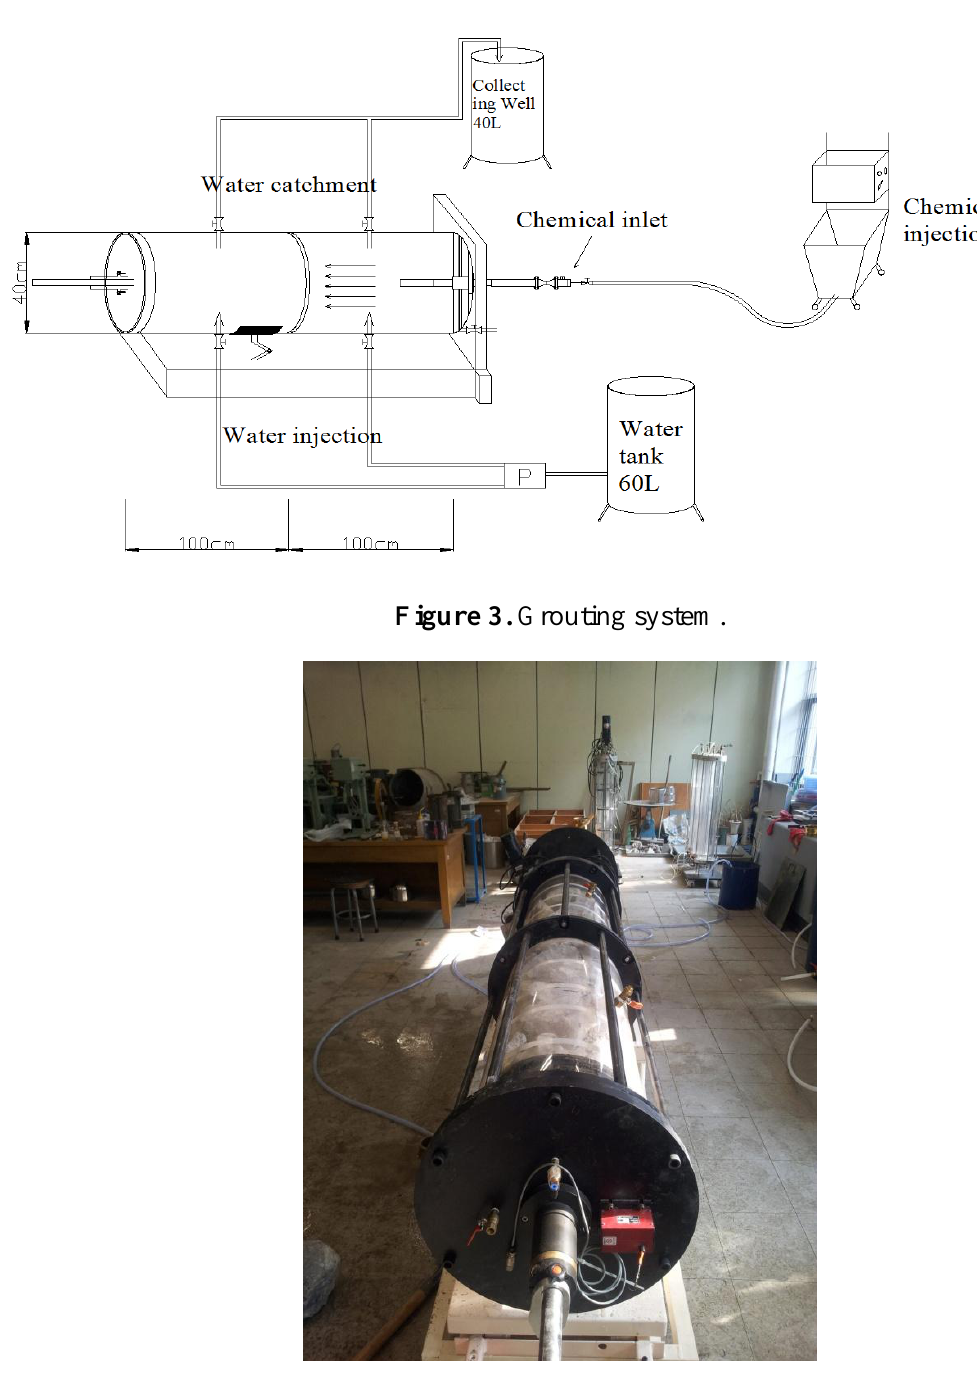
Figure 2. Schematic grouting and chemical injection system.